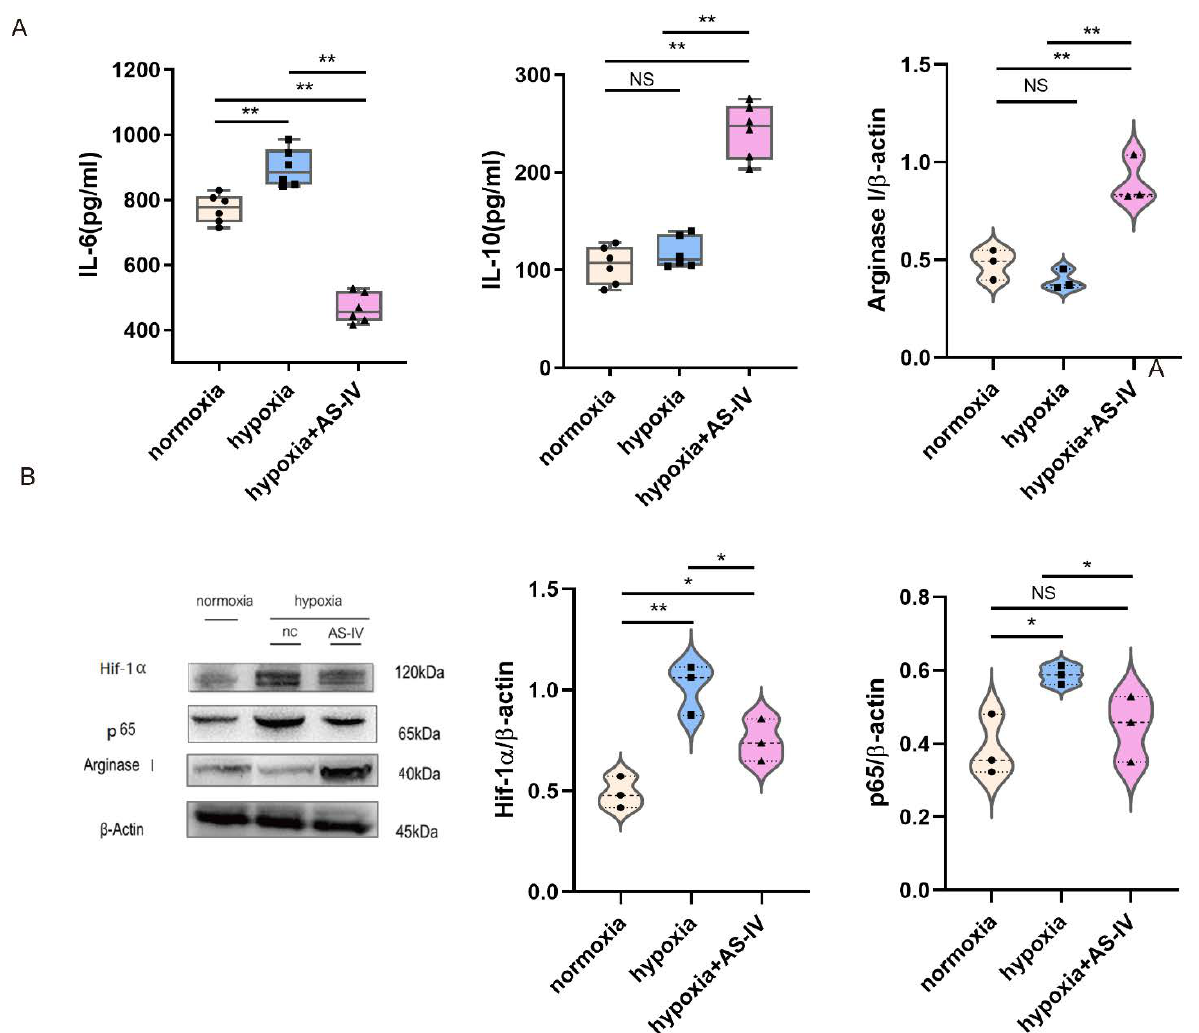
Figure 4. AS-IV promotes macrophage polarization toward M2 phenotype through suppressing NF- κ B p65/Hif-1 α pathway in vitro. ( A ) Levels of IL-6 and IL-10 in M1 cellular supernatants was analyzed by ELISA. ( B ) Western blot results of Arginase I, p65, and Hif-1 α in RAW 264.7 under normoxia, hypoxia, or hypoxia with AS-IV; n = 3 in each group, NS, no significance, * p < 0.05, * * p < 0.01.